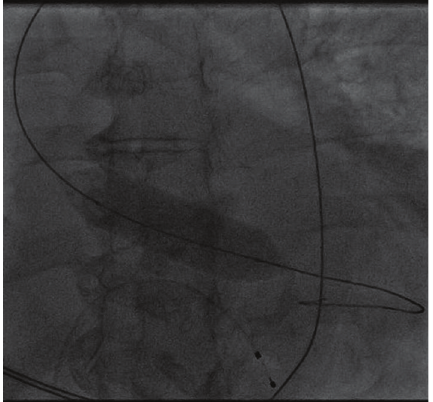
Figure 1: Severe aortic valve stenosis.